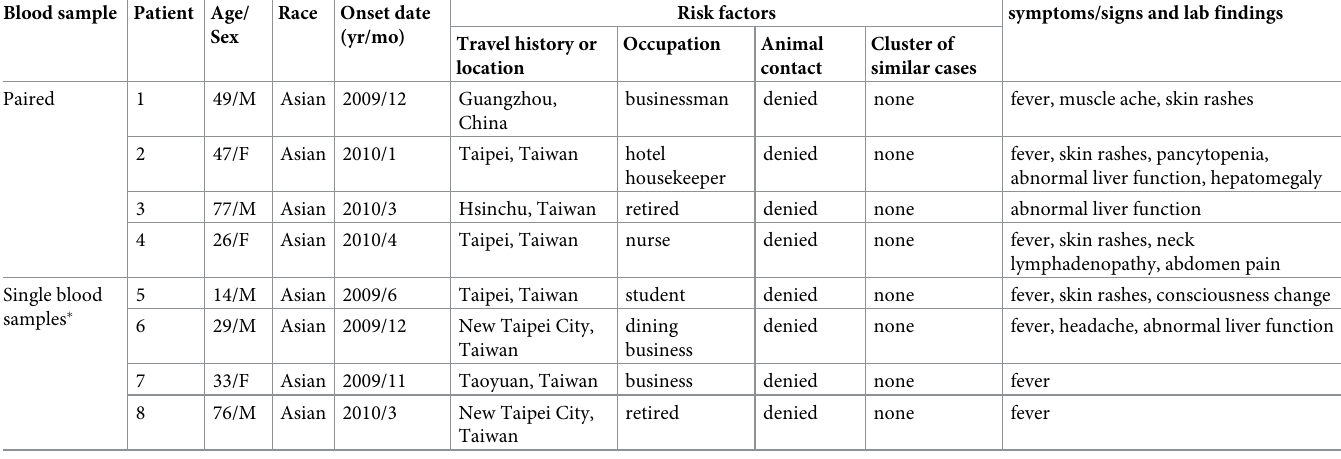
� The illness episode for which the serum sample was taken may not be caused by active R . felis